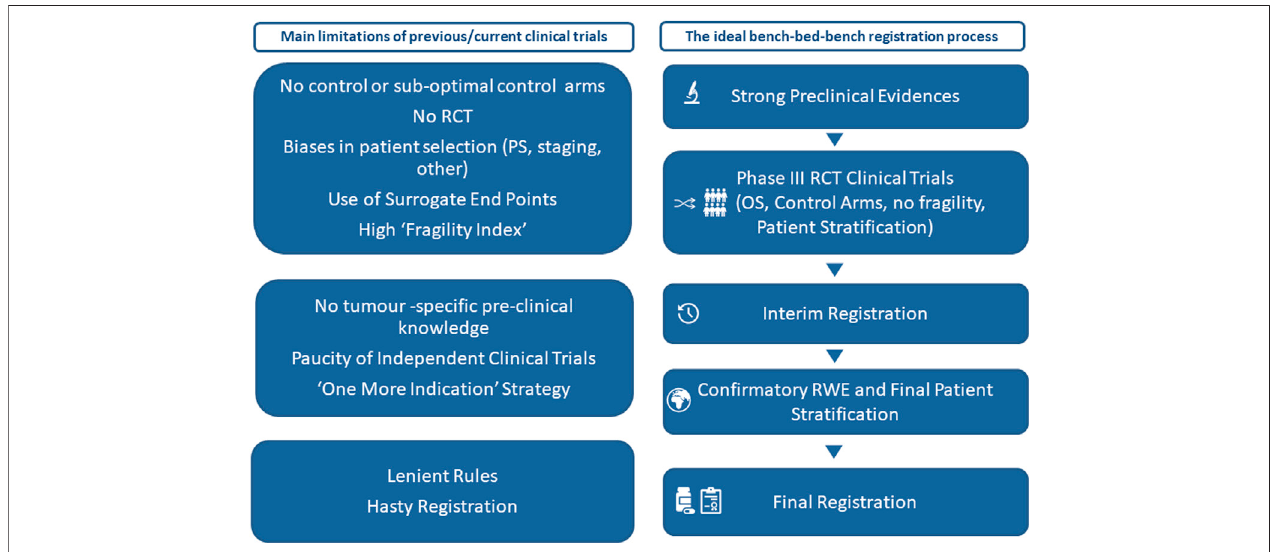
FIGURE 1 | Main limitations of many current clinical trials and an ideal bench – bed – bench registration process. OS: overall survival; PS: performance status; RCT: randomized clinical trials; RWE: real-world evidence.